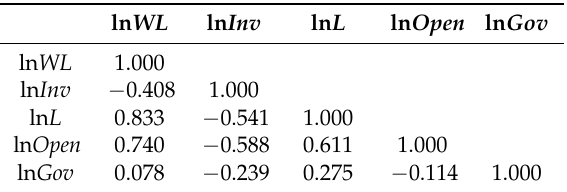
Table 4. Correlation coefficient matrix of variables.